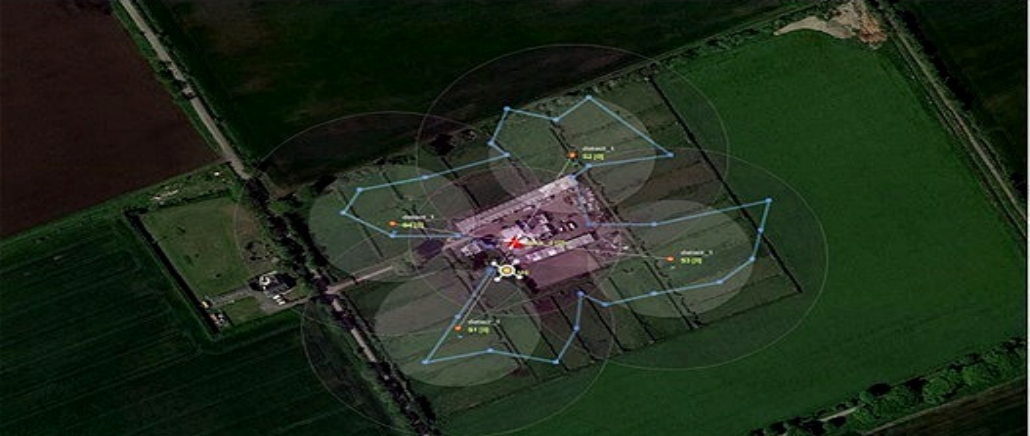
Figure 12. Cup-Carbon configuration of an agriculture field presenting 4 sensing nodes and random route of the mobile node with a centralized sink node.